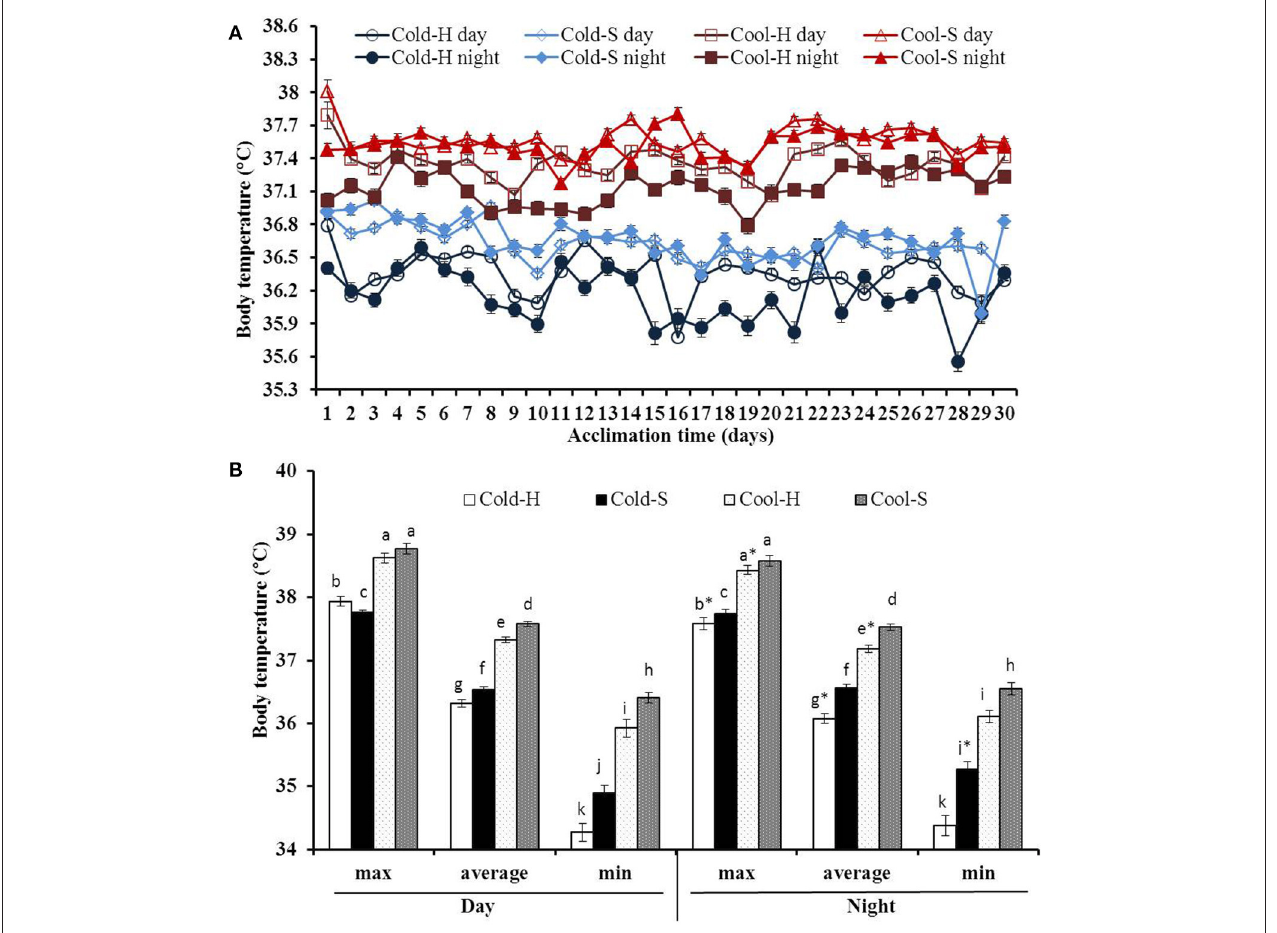
FIGURE 2 | Daytime and nighttime average T b s during acclimation (A) and differences in maximum, average and minimum Tb (B) of voles from different experimental groups. Cool-H ( n = 4); Cool-S ( n = 5); Cold-H ( n = 4); Cold-S ( n = 4). Values are means ± SE. *(star) indicates differences between daytime and nighttime values. Different small letters indicate the significant differences among experimental